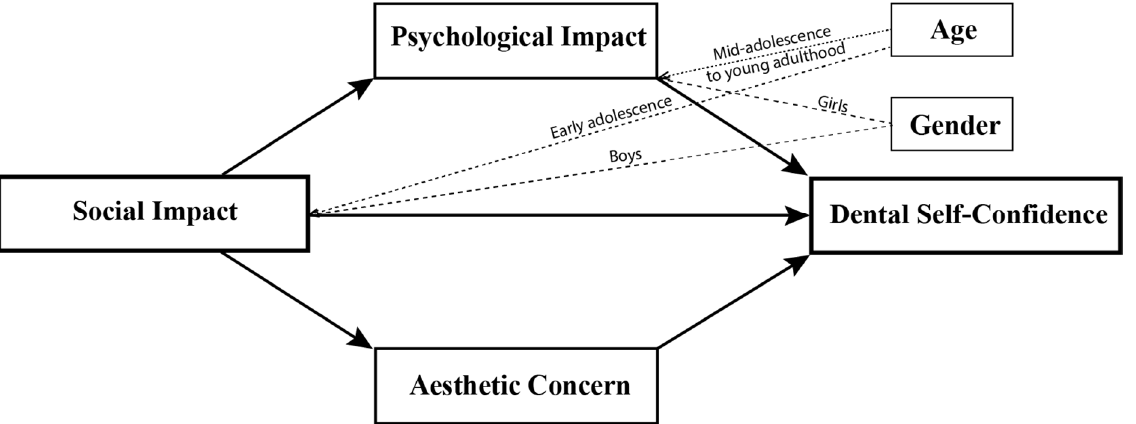
Figure 4. Final model showing that the relationship between social impact and dental self-confi- dence was mediated by psychological impact and aesthetic concern, and moderated by age and